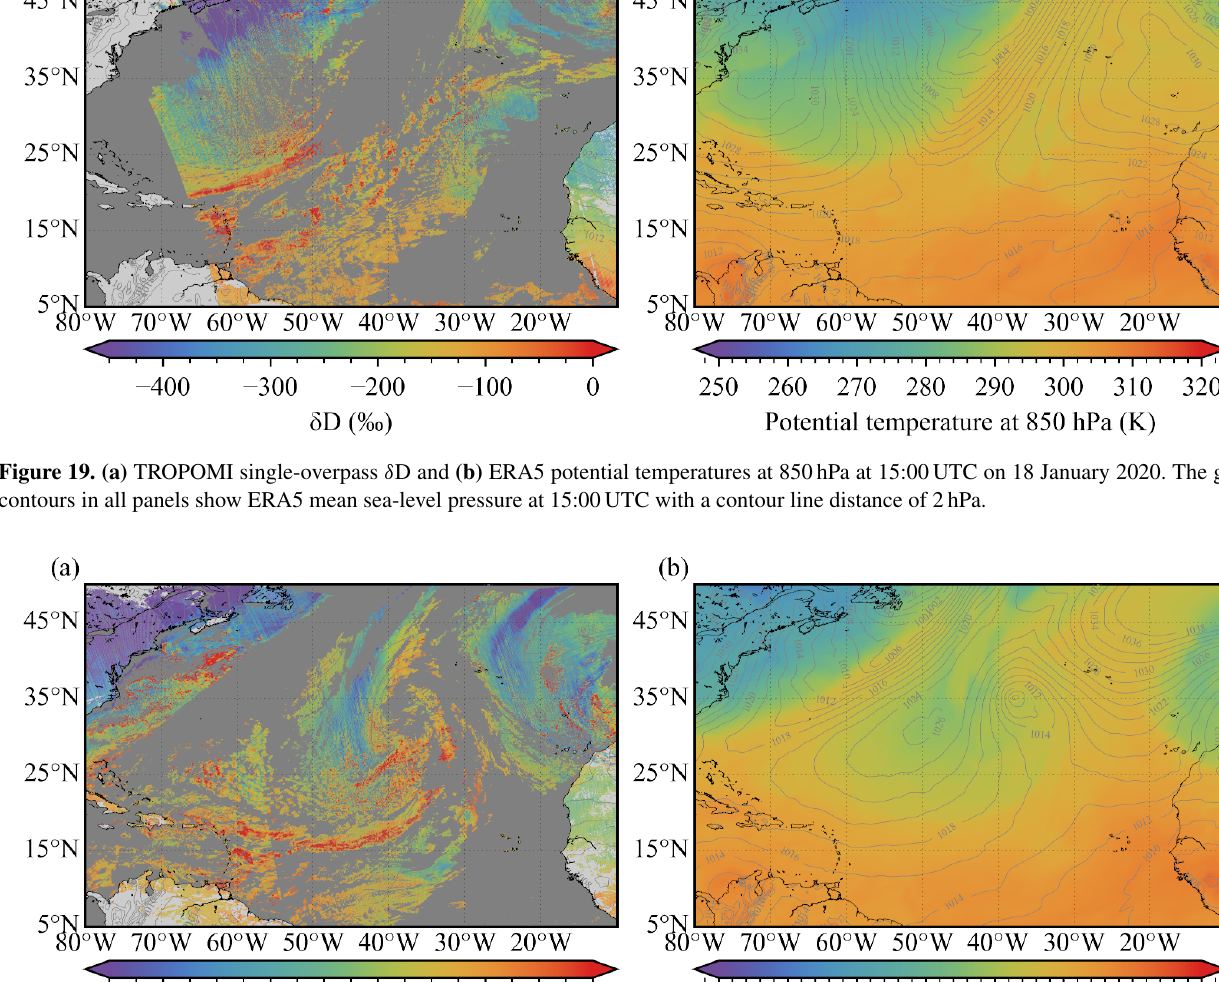
dow 2354.0 to 2380.5 nm. Surface albedos are slightly